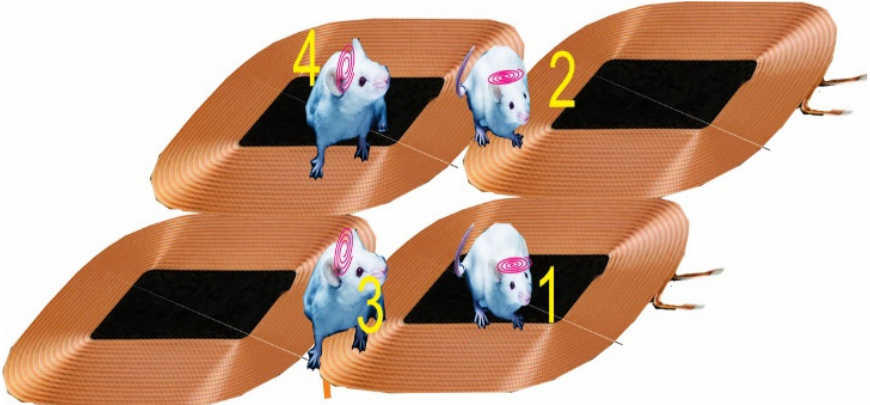
Figure 2. Different mode orientations of the transmitter and receiver coils relative to each other in the wireless power amplifier array. (In positions 1 and 2, the receiver coil is parallel to the transmitter coils, while in positions 3 and 4, the receiver coil makes a 90-degree angle with the transmitter coil).